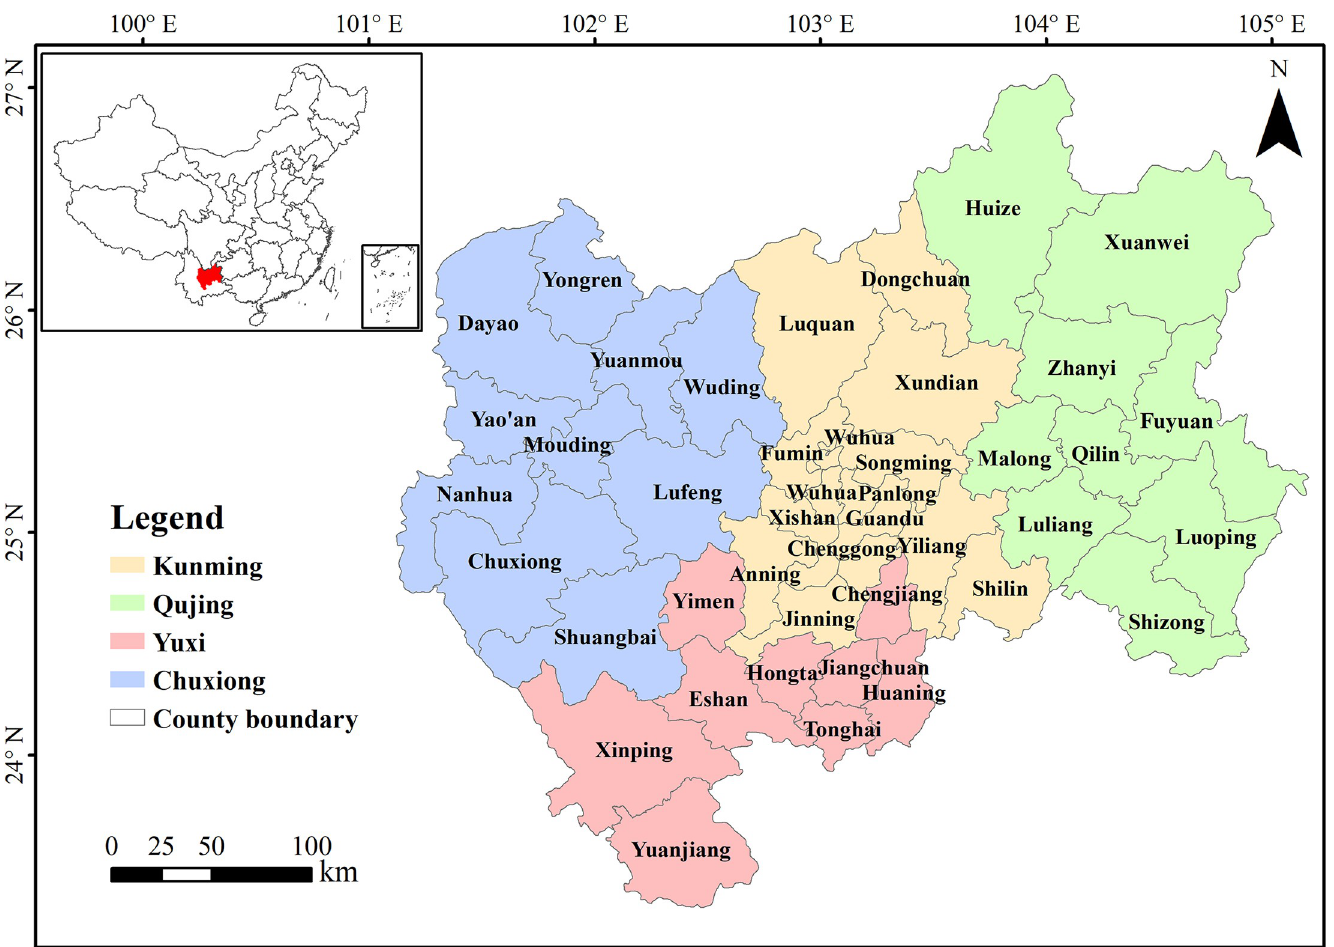
Fig 1. Location of the study